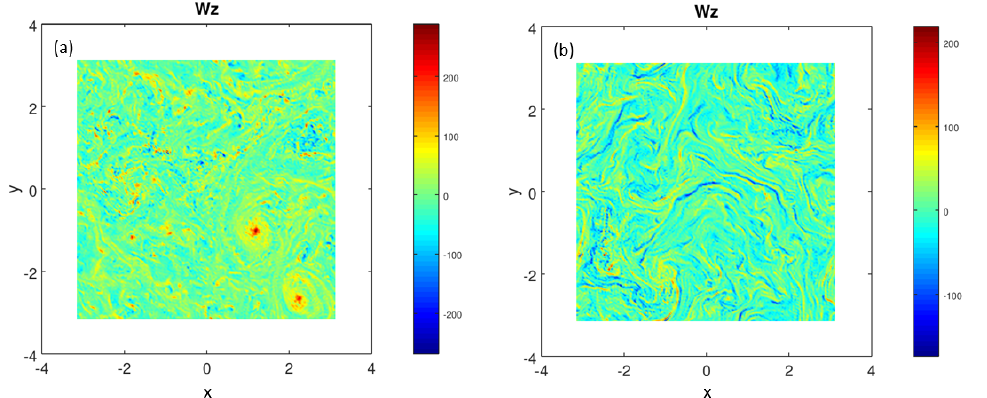
Figure 7. Horizontal cut of vertical vorticity ω z in PHT and PMHDT cases (runs 1 and 4) at St = 2 ε Ω t = 67. The elongated structures along the rotation axis observed in PHT case (left panel) are affected by the mean magnetic field: they are inhibited or distorted by the magnetic field (right panel) but their intensity is not strongly reduced. The flow structures look like